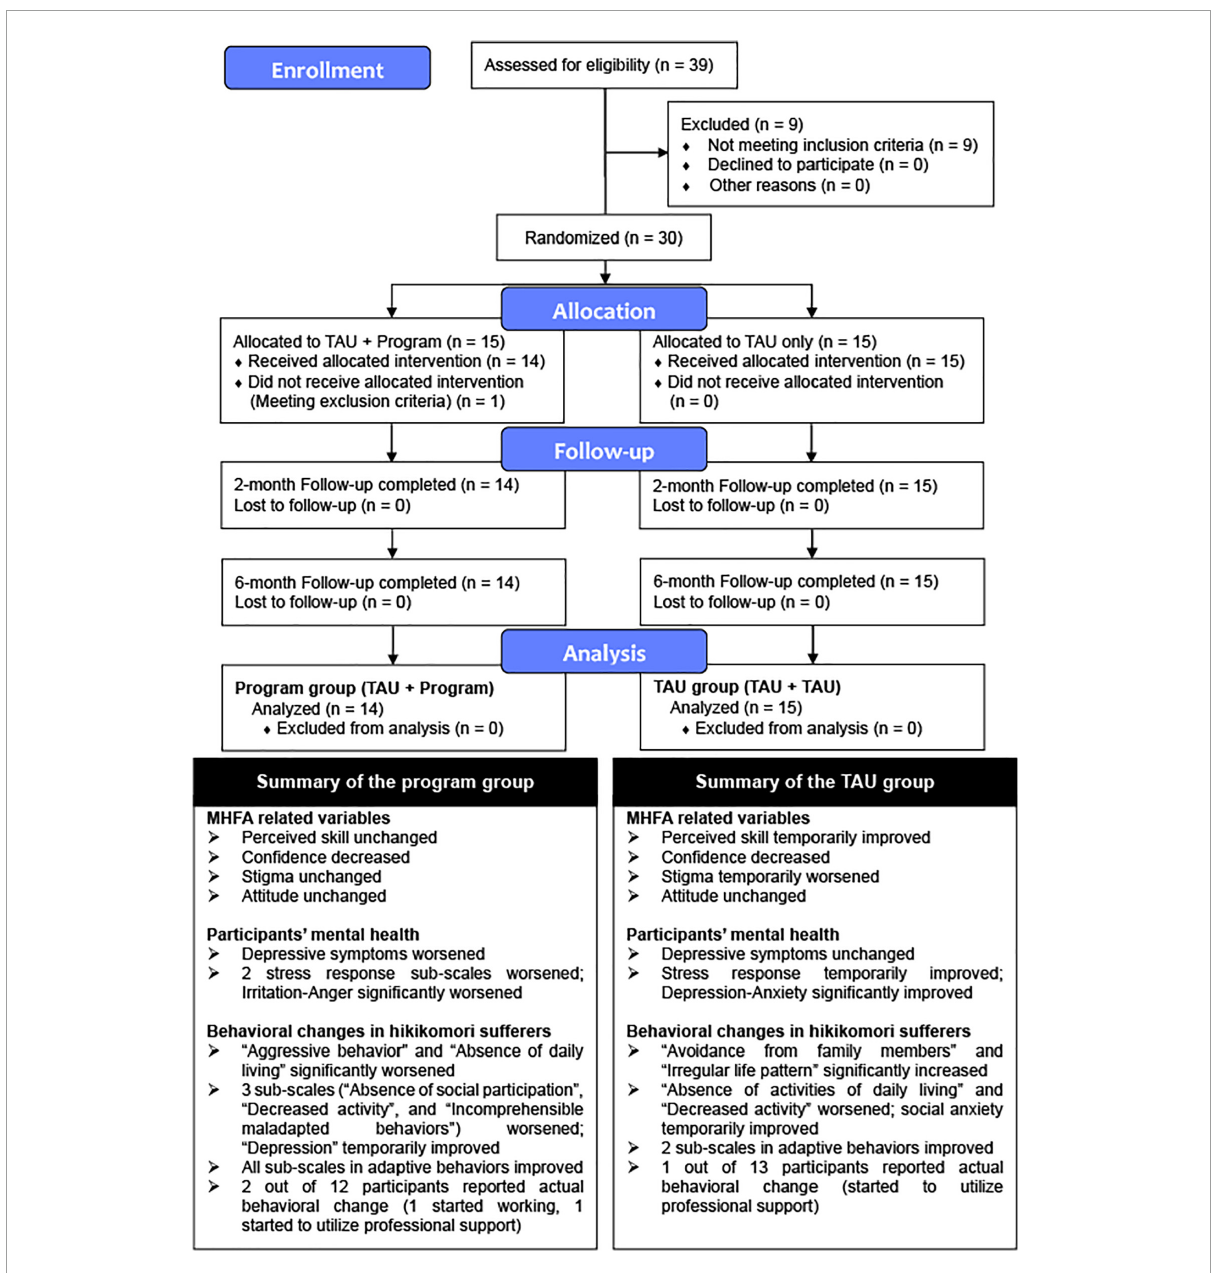
FIGURE1 CONSORT flow diagram and summary of the